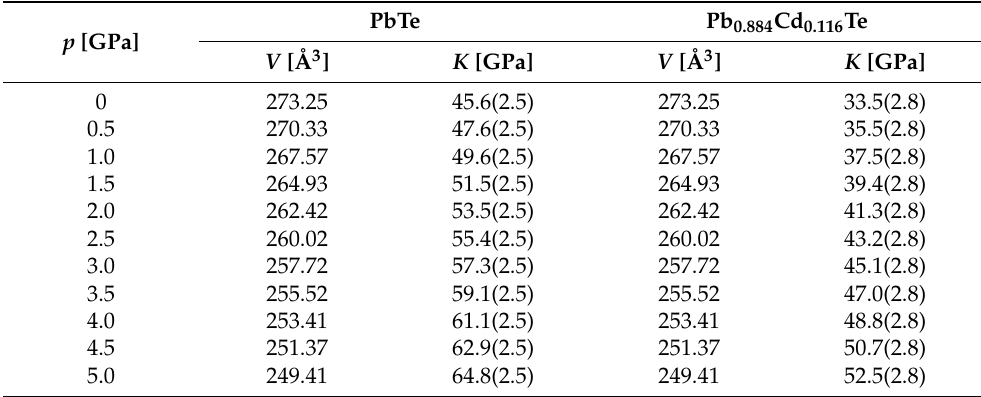
Table A4. Present unit cell volume and bulk modulus as a function of pressure, modeled using Equation (6) for PbTe and Pb 0.884 Cd 0.116 Te.